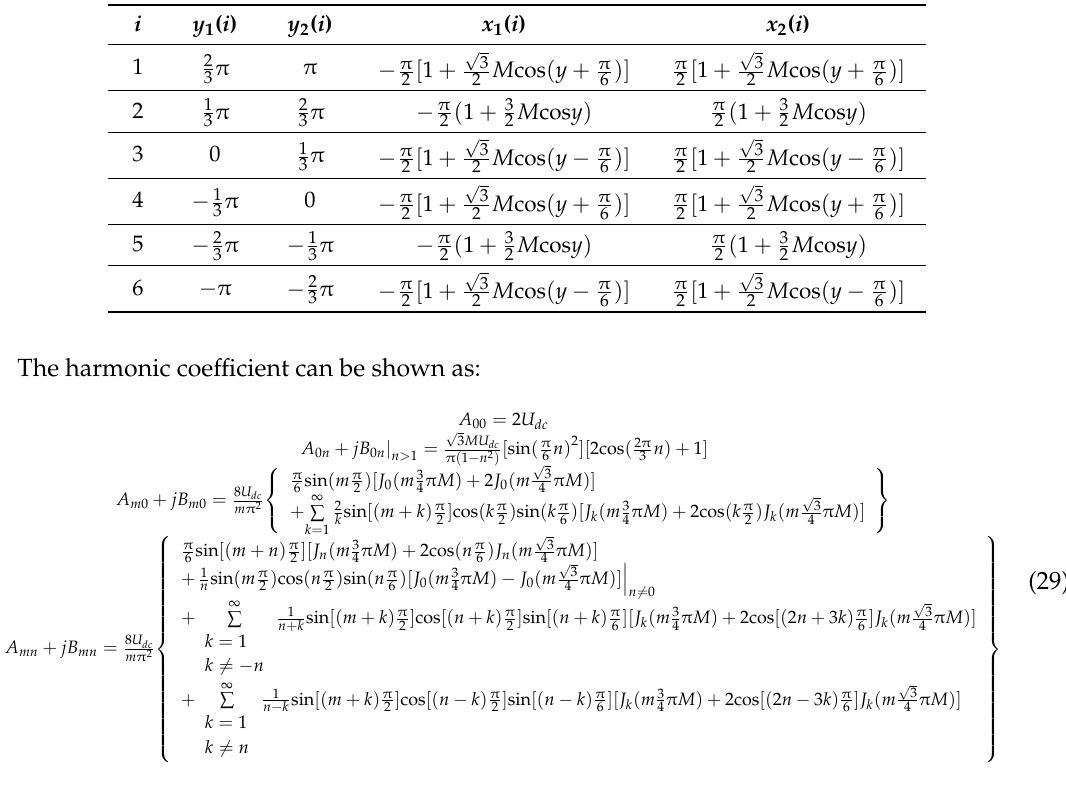
Table 3. Outer and inner integral limits for